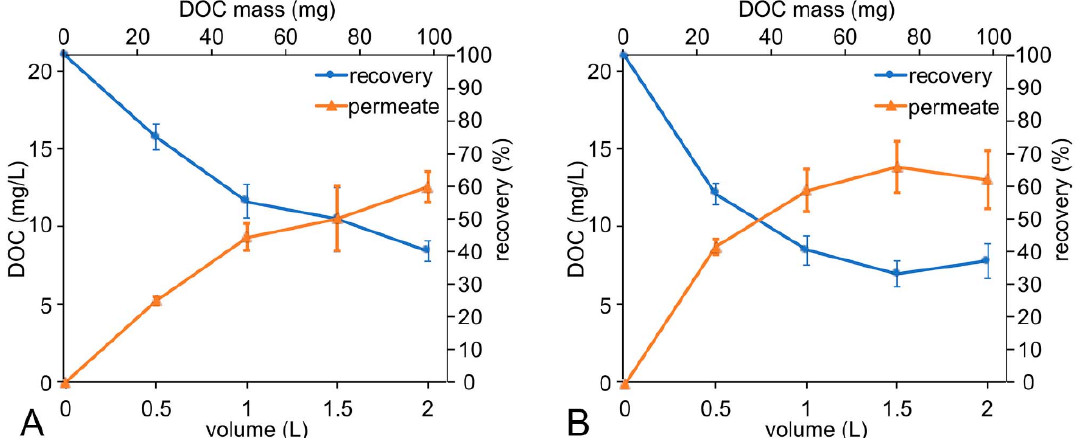
Figure 1. Mean values and sorption recoveries of dissolved organic carbon (DOC) with standard deviation ( n = 3) from 50 mg/L FA solution: ( A ) for the pre-packed (500 mg per 3 mL) Bond Elut PPL cartridges (experiment was run in triplicate); and ( B ) for the self-packed (500 mg per 3 mL) Bondesil PPL cartridges (experiment was run in triplicates). FA solution was discharged at a flow rate of 20 mL/min. DOC (mg/L) concentrations of permeates are shown on the left y -axis, the DOC recovery is demonstrated on the right y -axes.